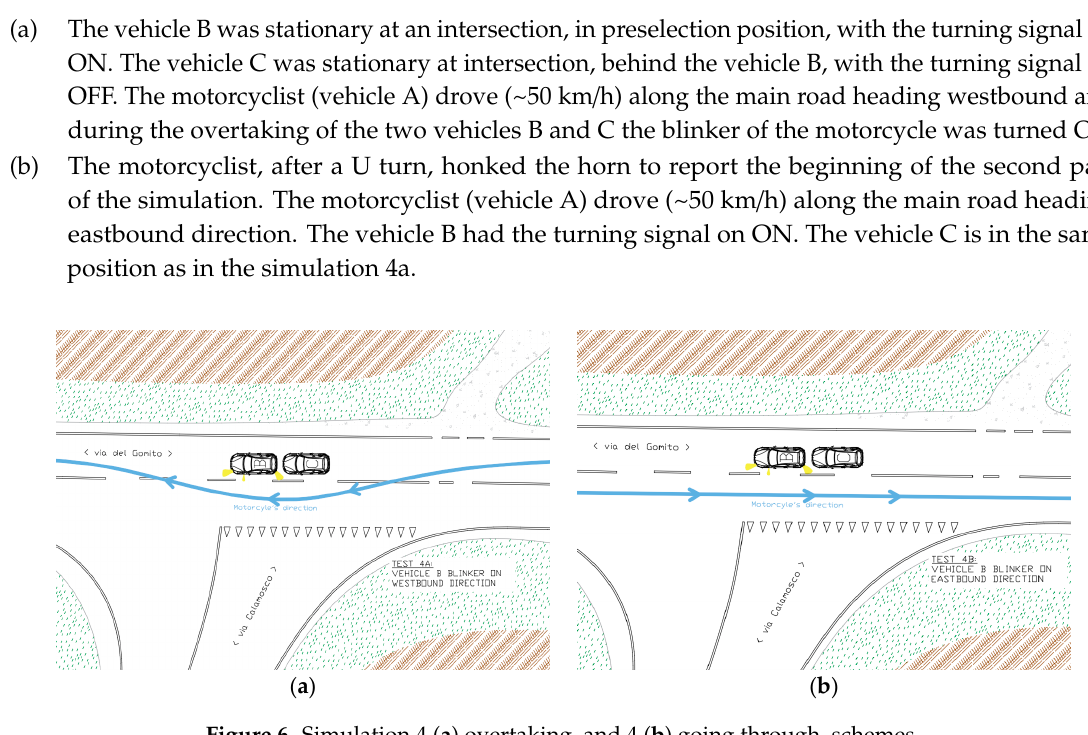
Figure 6. Simulation 4 ( a ) overtaking, and 4( b ) going through, schemes.